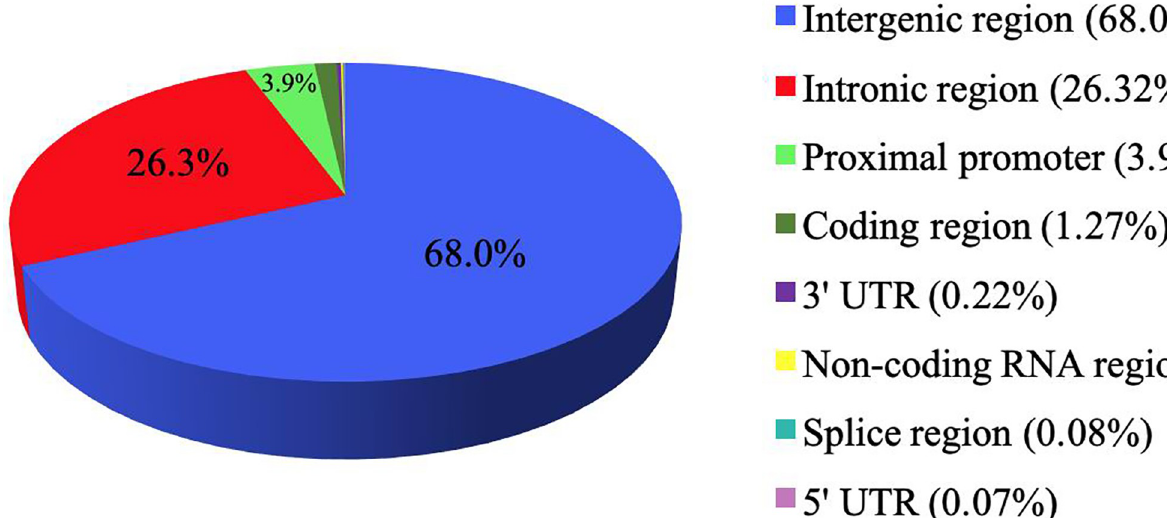
Fig 4. Genomic distribution of meSNPs. Classification of meSNPs according to sequence ontology (SO term) provided by Ensembl.